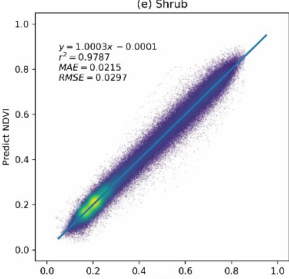
Figure 4. The accuracy of the radial basis function network (RBFN)-based NDVI prediction model over different vegetation types: a brighter color (yellow) denotes a higher point density, and a darker color (deep blue) denotes a lower point density.